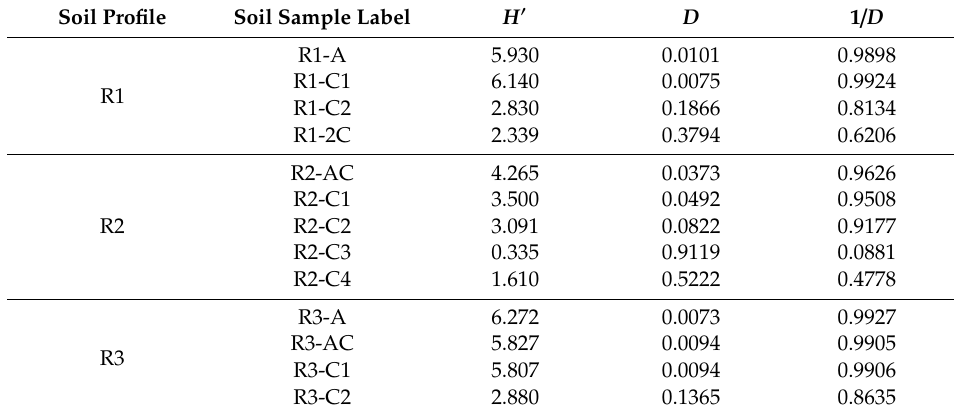
Table 2. Calculated diversity indices at genetic distance of 3% for studied soil